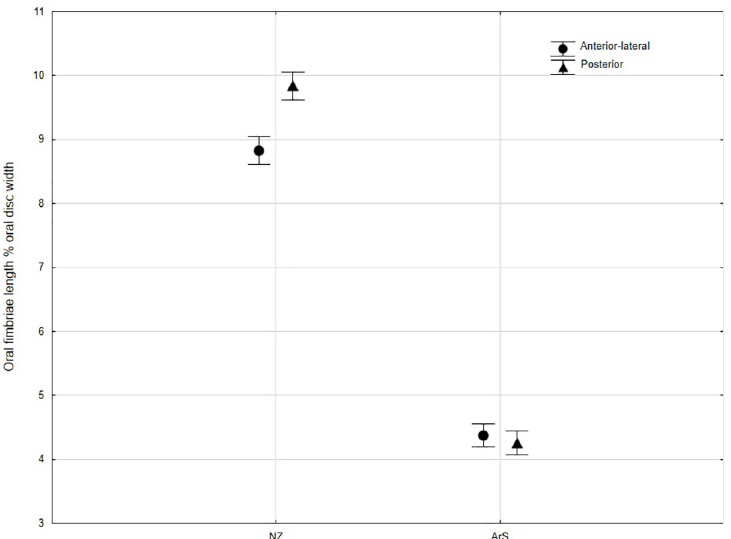
Fig 8. Plot of oral fimbriae length as a percentage of oral disc width for immature NZ G . australis from the Waikawa River and immature G . macrostoma from the Santa Cruz River. For both anterior-lateral and posterior regions, the mean ± 95% confidence interval is displayed. Error bars that do not overlap depict significant differences between regions and lamprey species ( p < 0.05).